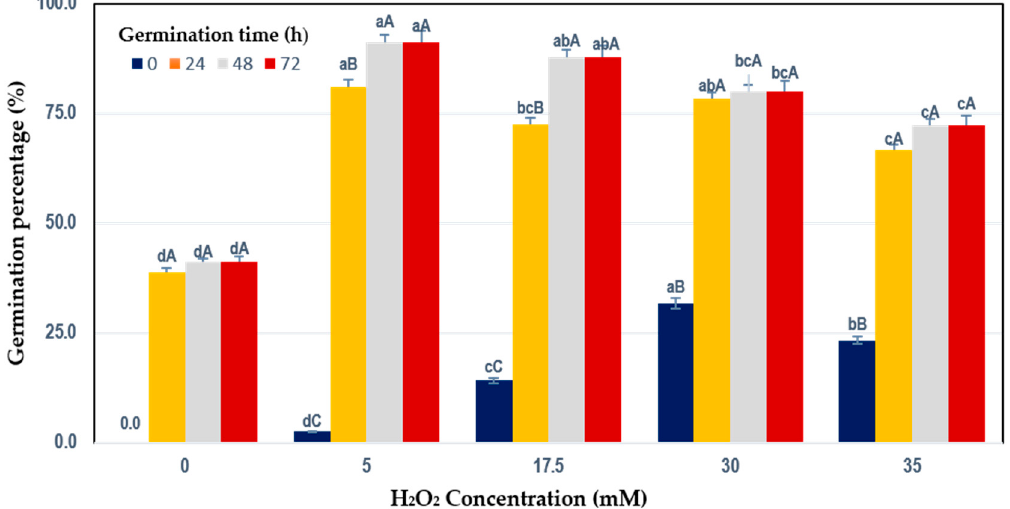
Figure 1. Germination percentage of chickpea seeds elicited with H 2 O 2 at different concentrations. Values are the mean of three replicates. The same uppercase letter between germination times means no significant difference ( p < 0.05); the same lowercase letter between H 2 O 2 concentrations at the same germination time means no significant difference ( p < 0.05).